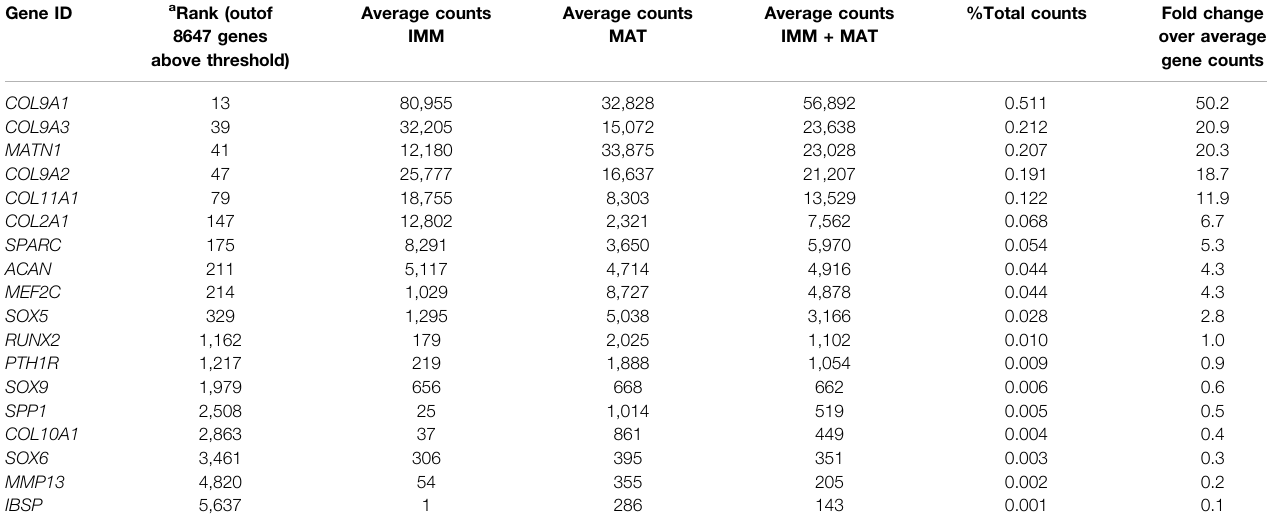
TABLE 2 | Normalized gene expression counts of relevant cartilage genes in chick